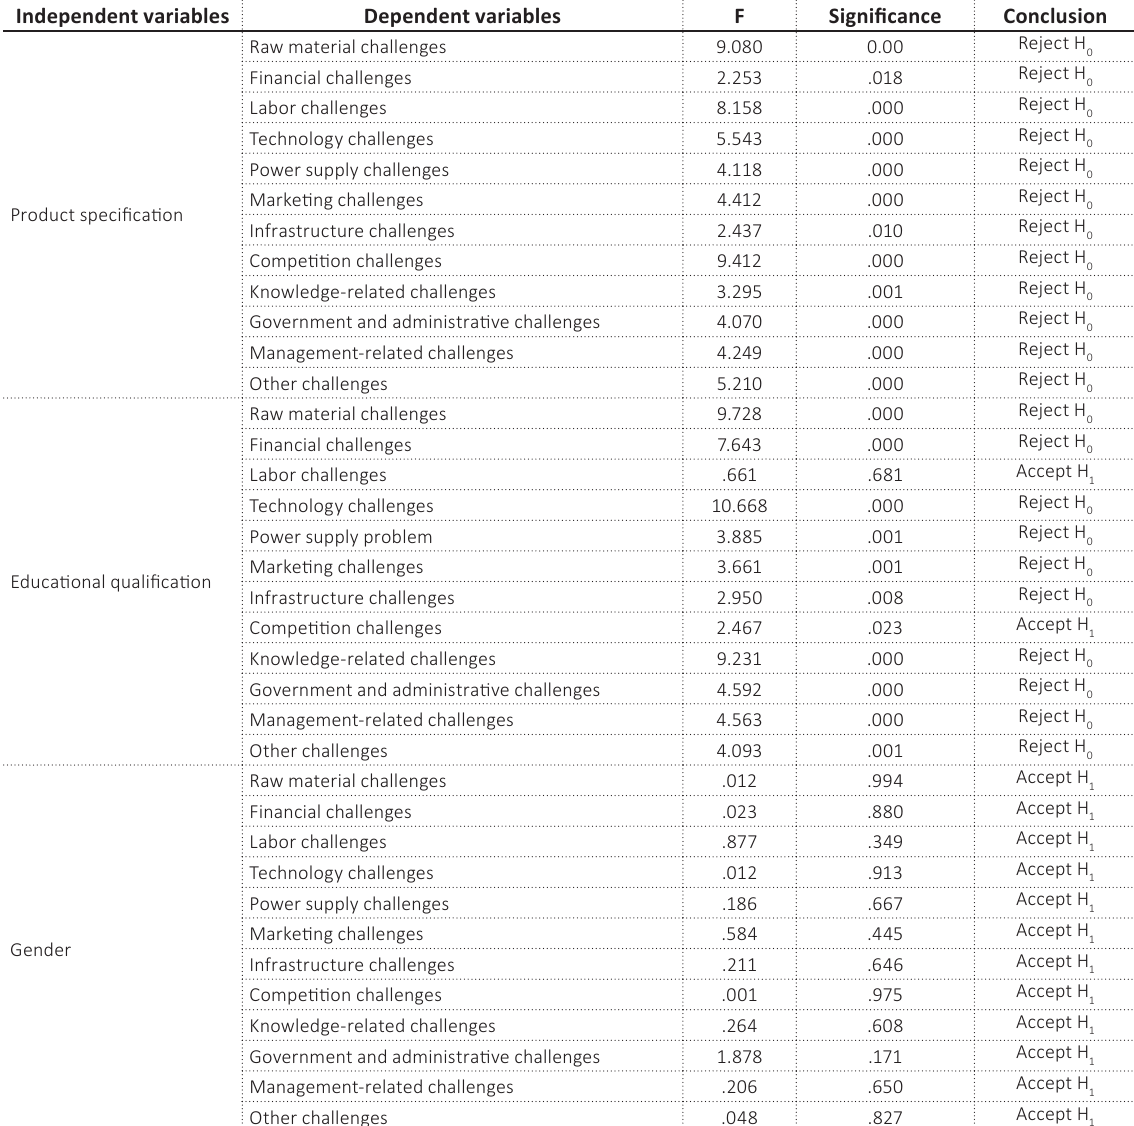
Table 16. Multivariate ANOVA test